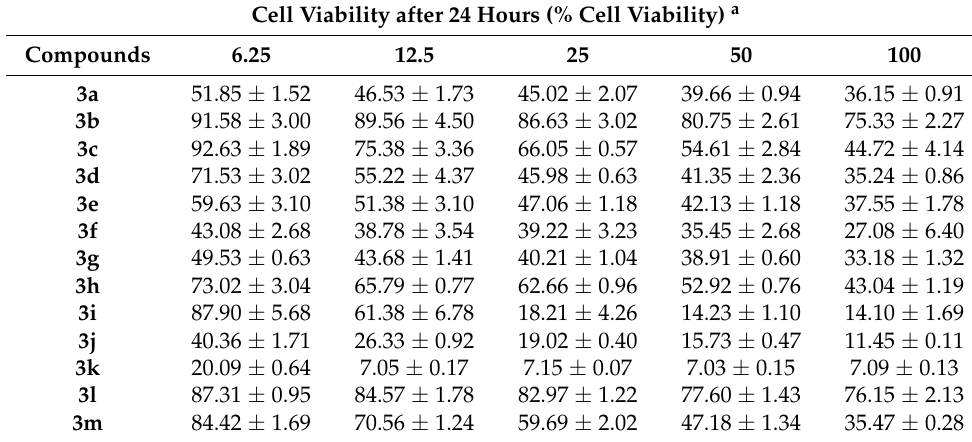
Table 3. In vitro cytotoxicity data of